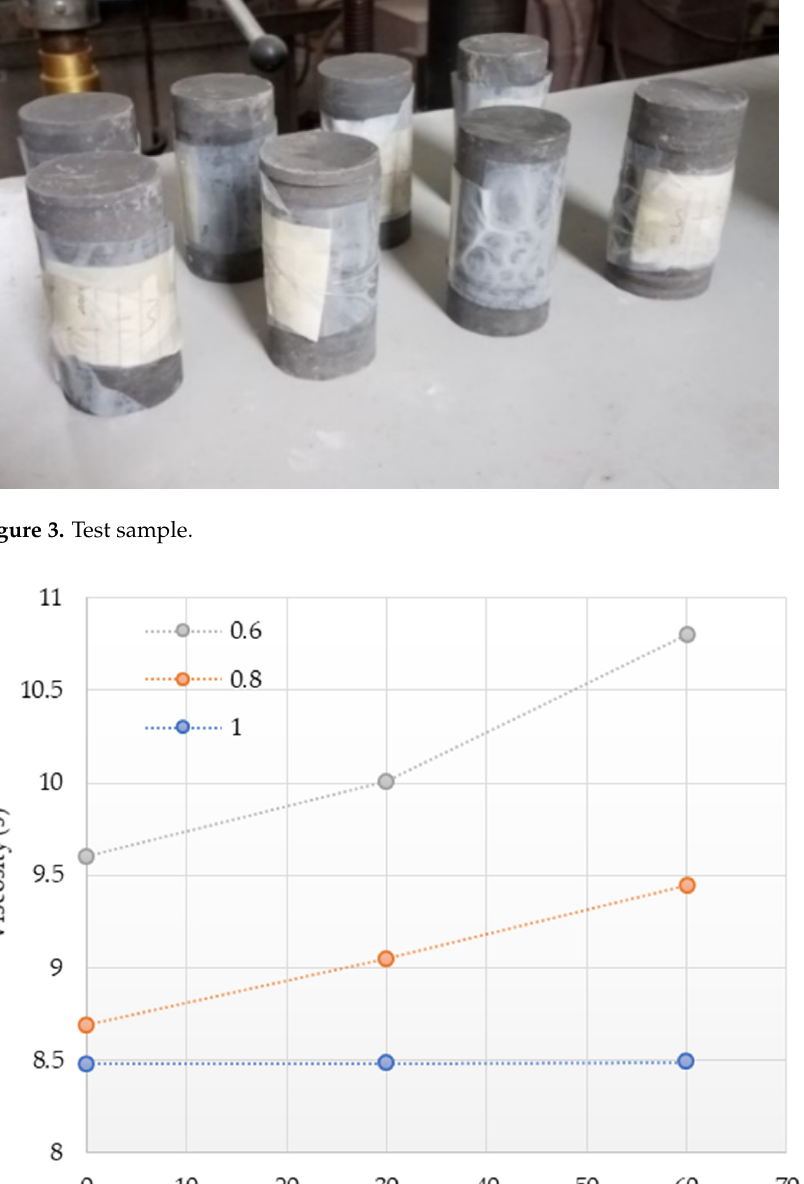
Figure 3. Test sample .